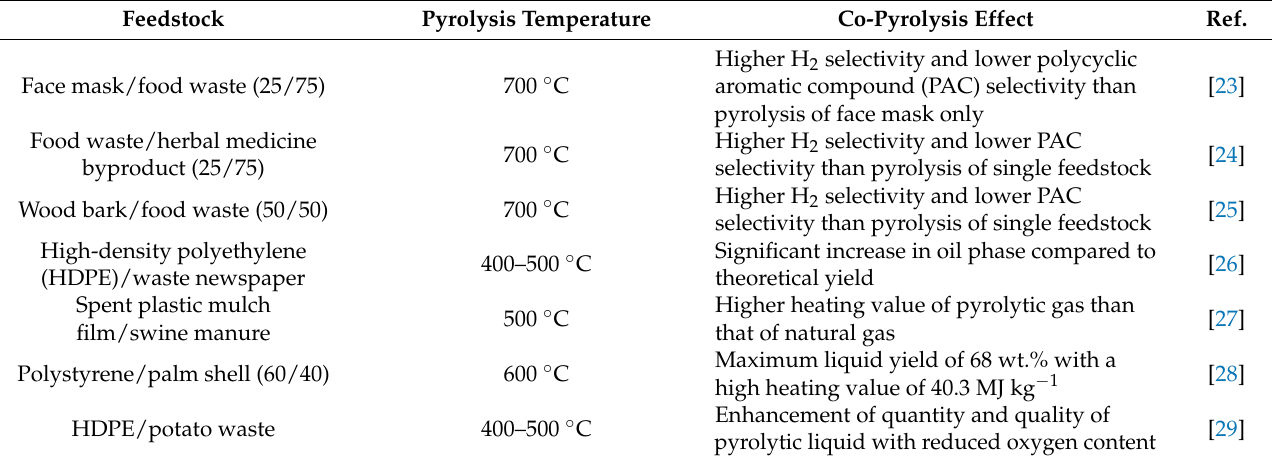
Table 1. Effect of co-pyrolysis for the treatment of various